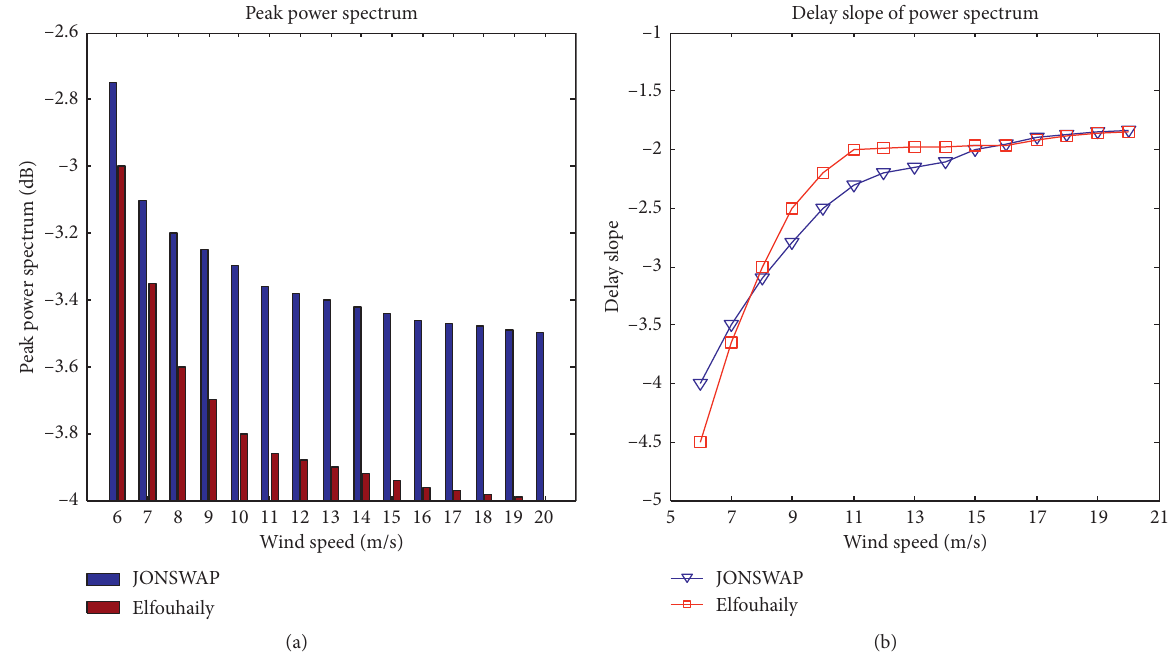
Figure 2: Comparison of peak power and delay slope of power spectrums under different wind speeds.